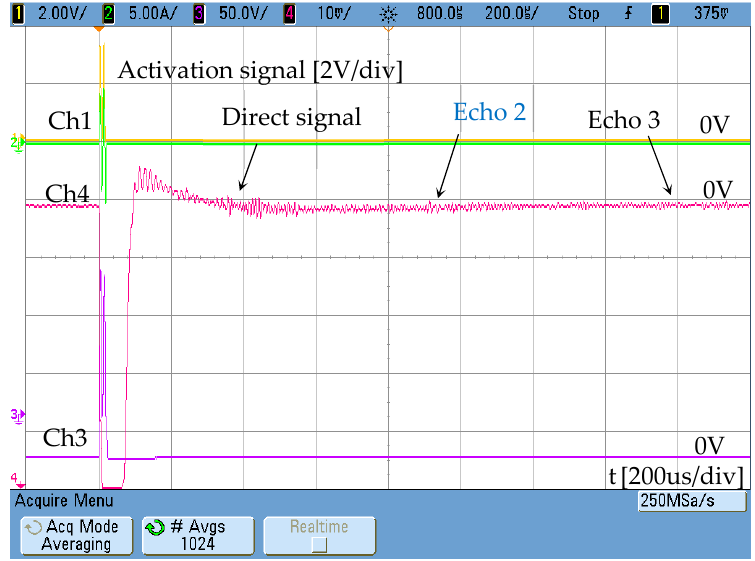
Figure 17. Magnetostrictive transducer response without DC bias, Ch4: [10 mV / div]. Ch1 shows the activation signal of the power stage [2 V / div] and Ch3 the voltage at resonant circuit [50 V / div]. The maximum AC current is 5 A.